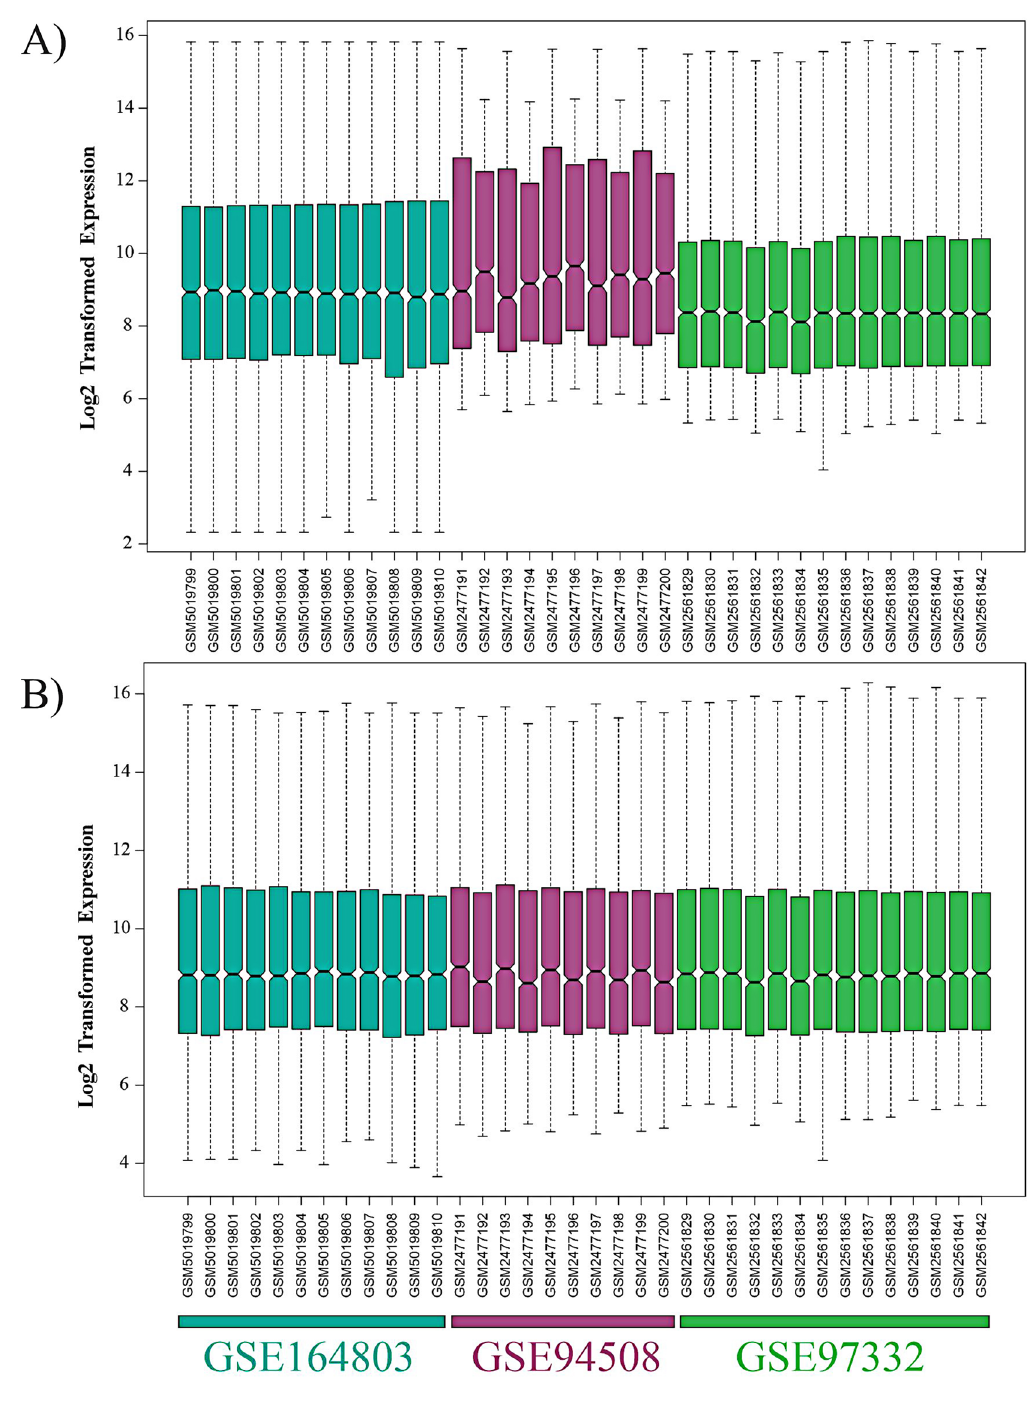
Figure 2. The box plots illustrate the overall expression profiles of three Affymetrix gene chips ( A) after being normalized by normalize quantiles method, ( B) after batch effect removal by ComBat method using the sva package in R